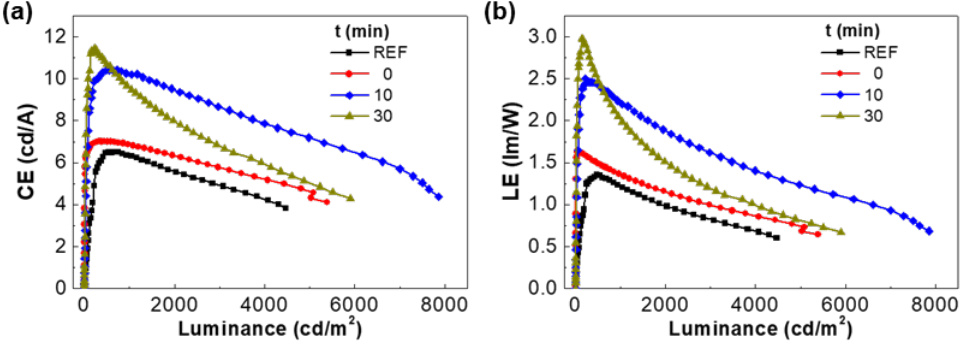
Figure 3. Efficiency as a function of luminance for the OLEDs with the P3HT layers annealed at 140 °C for 0, 10, and 30 min: ( a ) current efficiency (CE), ( b ) luminous efficiency (LE). Note that the OLED without any P3HT layer is marked as REF (reference device).